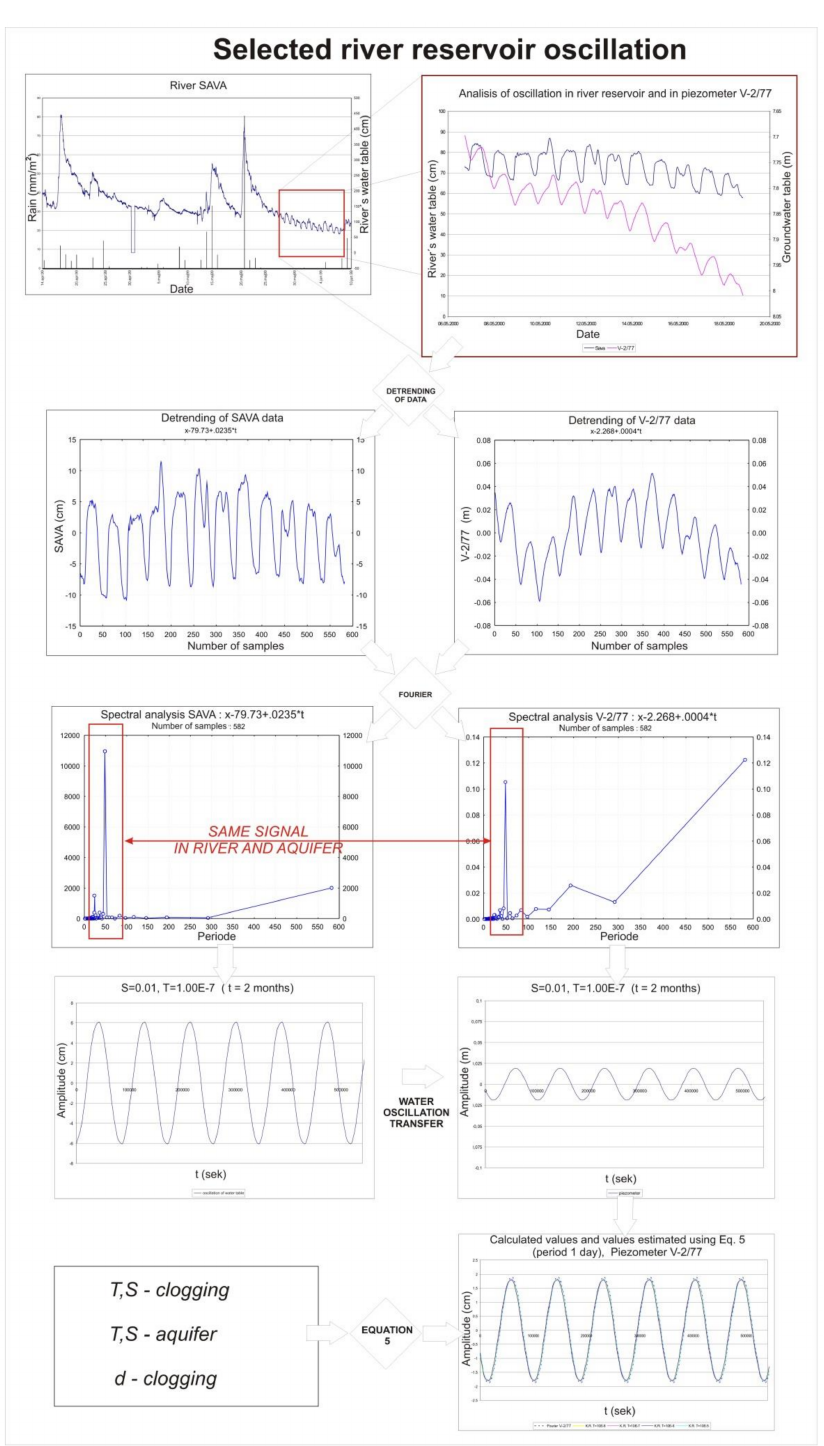
Figure 8. Flow-chart of analysis of riverbed clogging by analysis of river reservoir oscillation and groundwater oscillation in the piezometer close enough to the